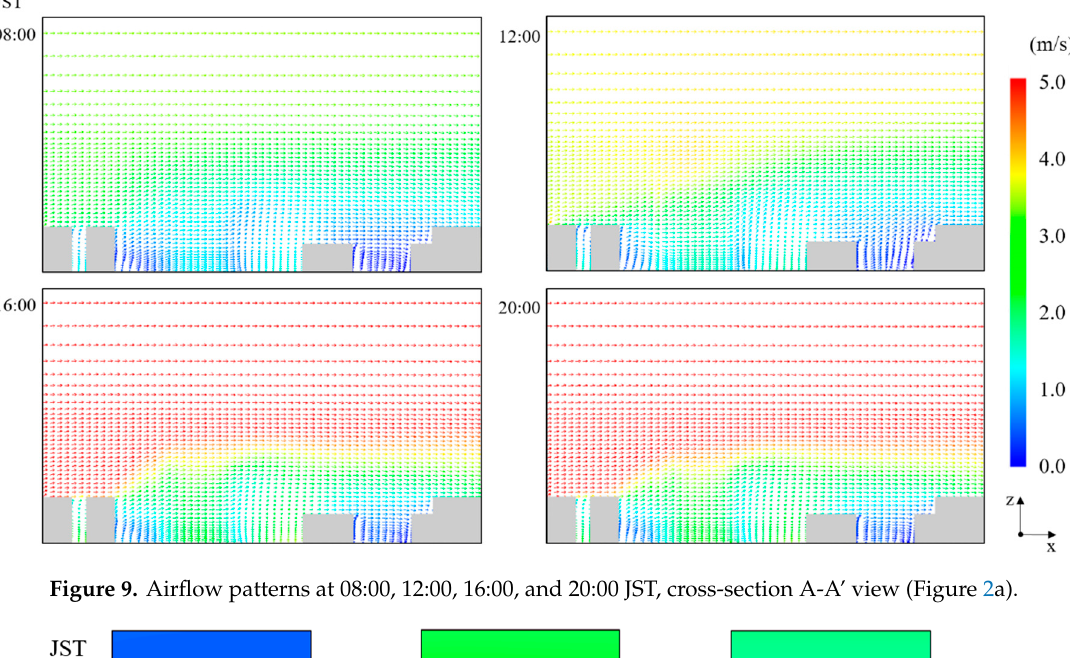
Figure 9. Airflow patterns at 08:00, 12:00, 16:00, and 20:00 JST, cross-section A-A’ view (Figure 2a).